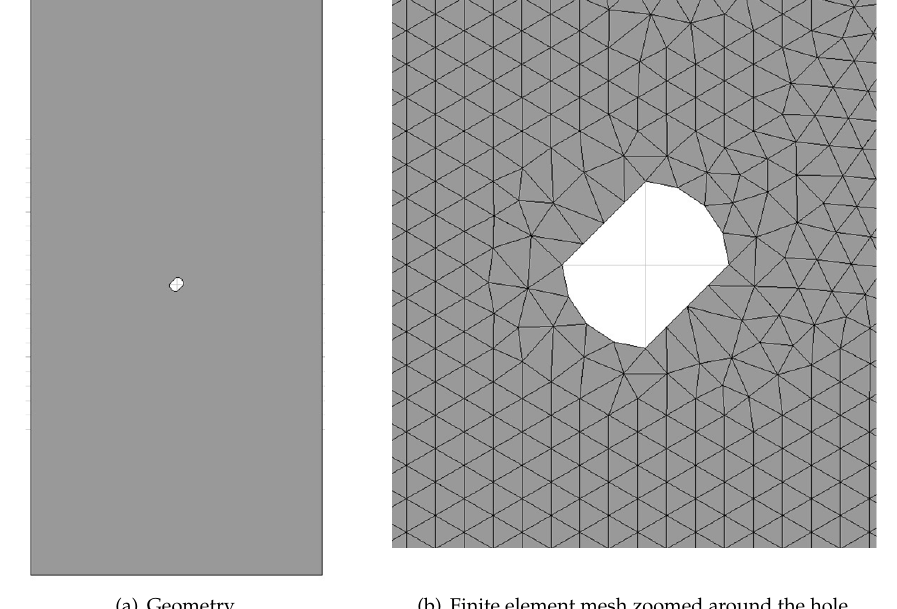
Figure 5. Uniaxial tension of a perforated strip: problem